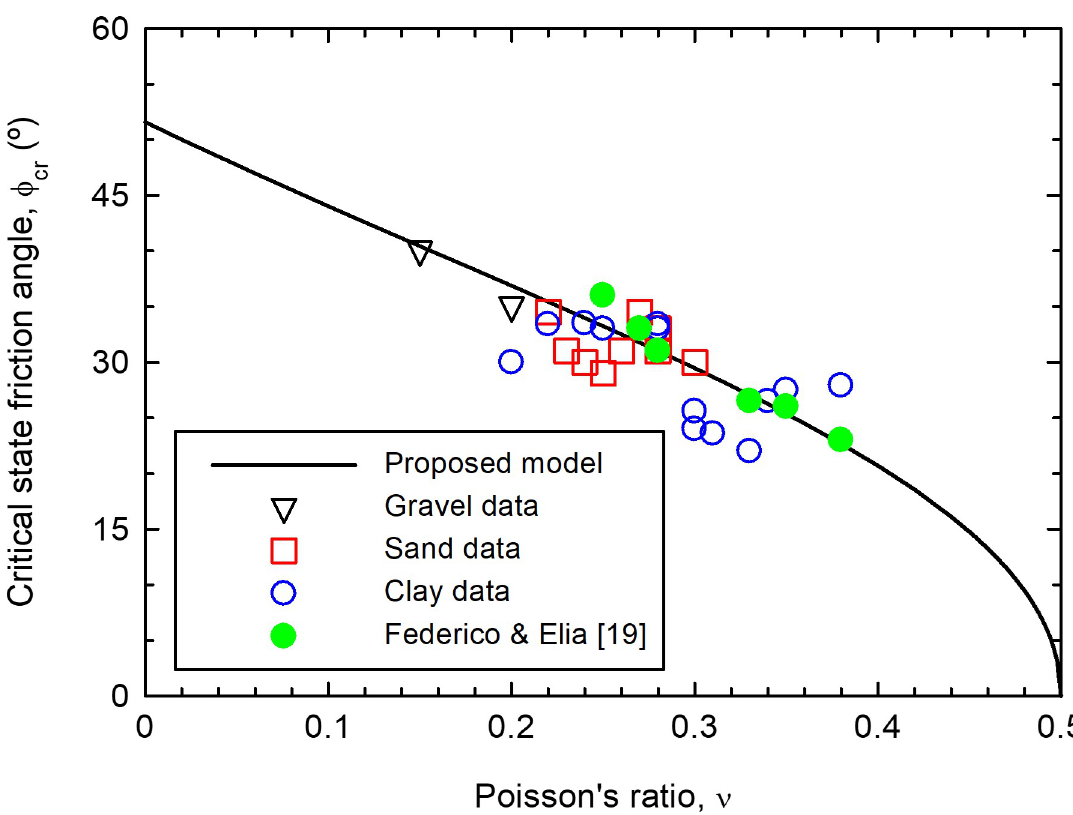
Fig 3. Relationship between Poisson’s ratio and critical state friction angle for